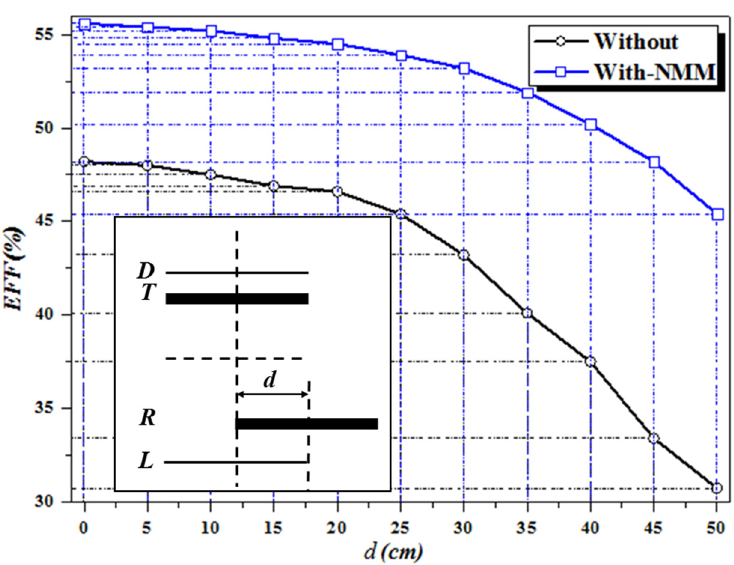
Figure 9. Comparison of system efficiency before and after NMM loading during lateral misalignment.